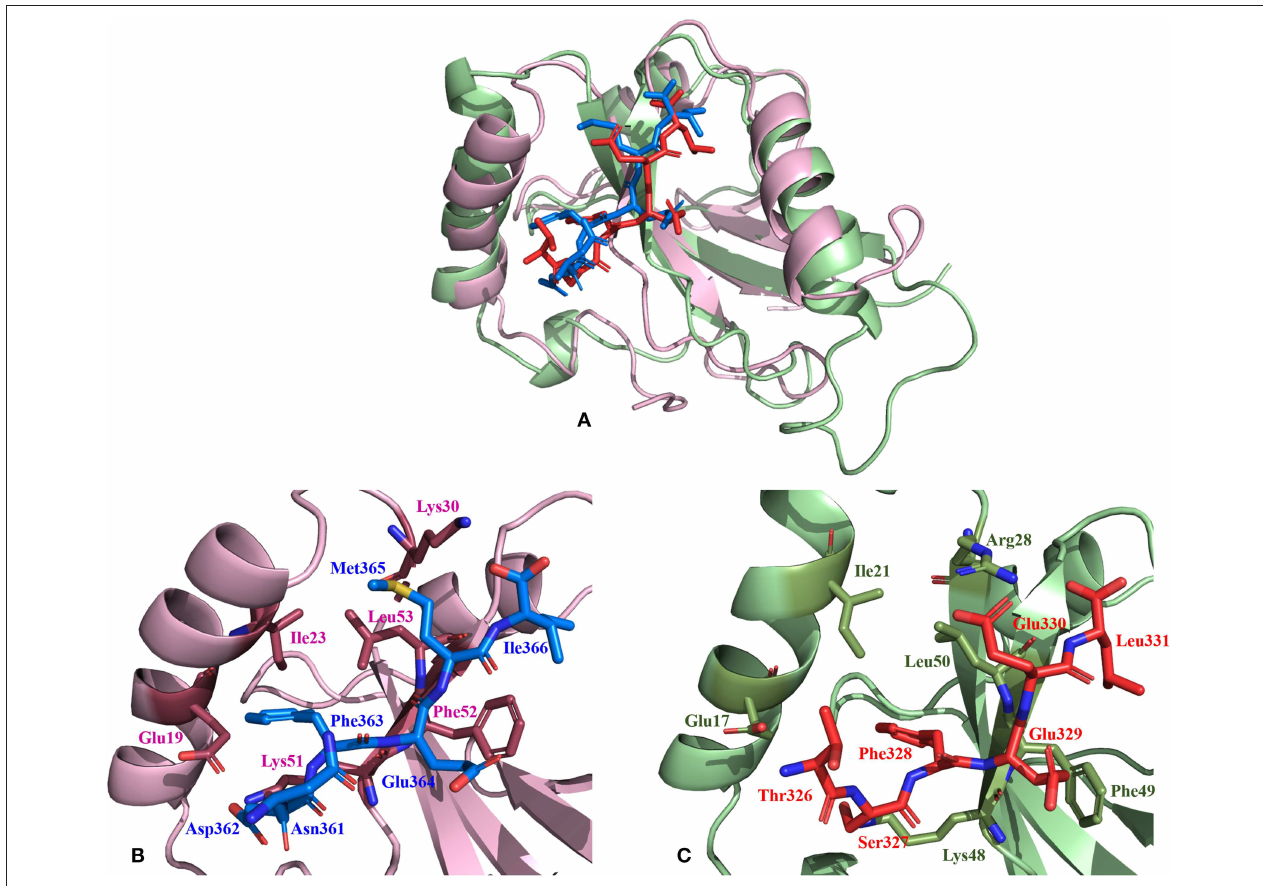
FIGURE 6 | Relative comparison of the binding interactions of Hs Sec62 NDFEMI— Hs LC3 and Pf Sec62 TSFEEL— Pf Atg8 peptide-protein complexes. (A) Super-positioning of Hs Sec62 NDFEMI— Hs LC3 (shown in pink) and Pf Sec62 TSFEEL— Pf Atg8 (shown in green color) showing similarities in the peptide-protein complexes; (B) Binding interactions of Hs Sec62 NDFEMI with the residues of W-site of Hs LC3 and (C) binding interactions of Pf Sec62 TSFEEL with the residues of W-site of Pf